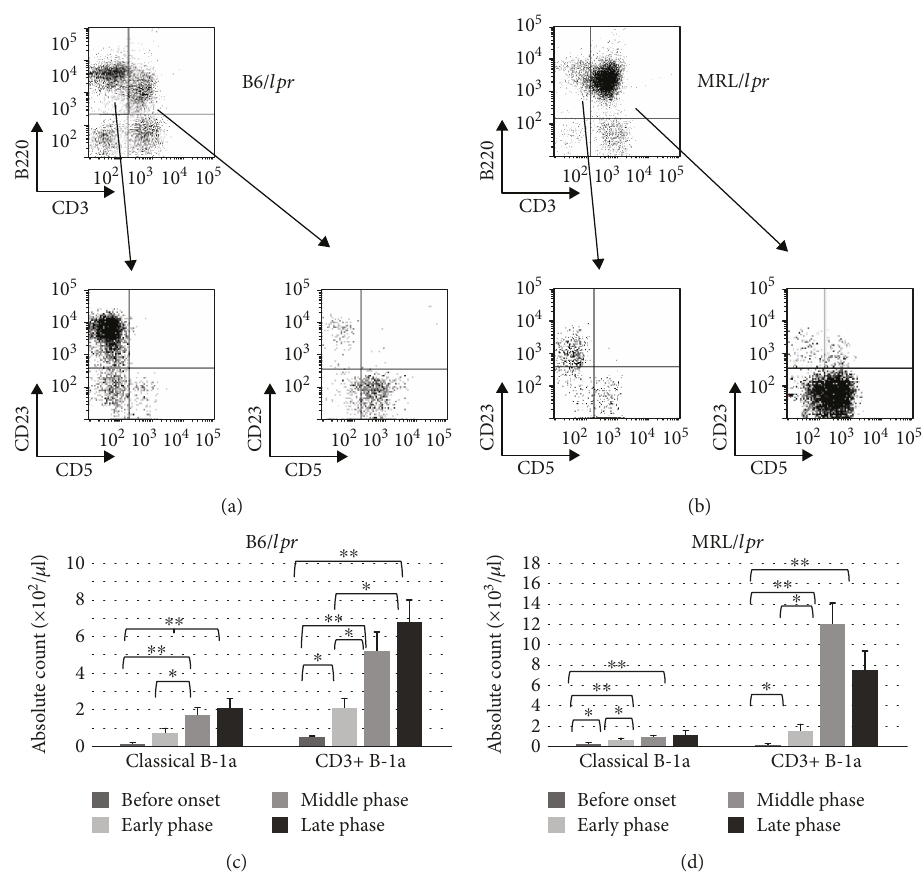
Figure 4: Detection of B-1a cells in the CD3+CD4-CD8-B220+ population. Peripheral blood cells obtained from the B6/ lpr mice ( n = 18 ) were stained with CD3, B220, and CD5 antibodies and analyzed using fl ow cytometry. Representative fl ow cytometry plots (a) and absolute count of classical B-1a cells and CD3+ B-1a cells (c) are shown. Peripheral blood cells obtained from the MRL/ lpr mice ( n = 21 ) were stained with CD3, B220, and CD5 antibodies and analyzed using fl ow cytometry. Representative fl ow cytometry plots (b) and absolute count of classical B-1a cells and CD3+ B-1a cells (d) are